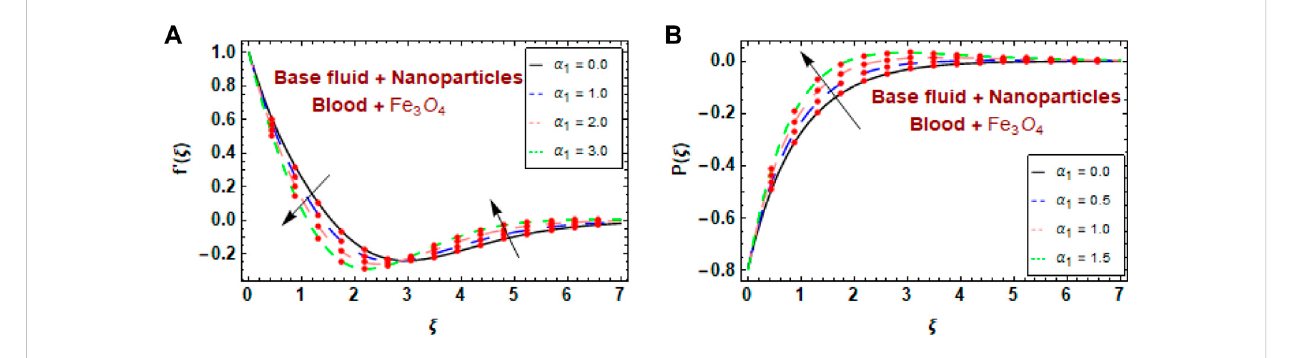
FIGURE 5 (A,B) Variations in f ′ ( ξ ) and p ( ξ ) for distinct numbers of α 1